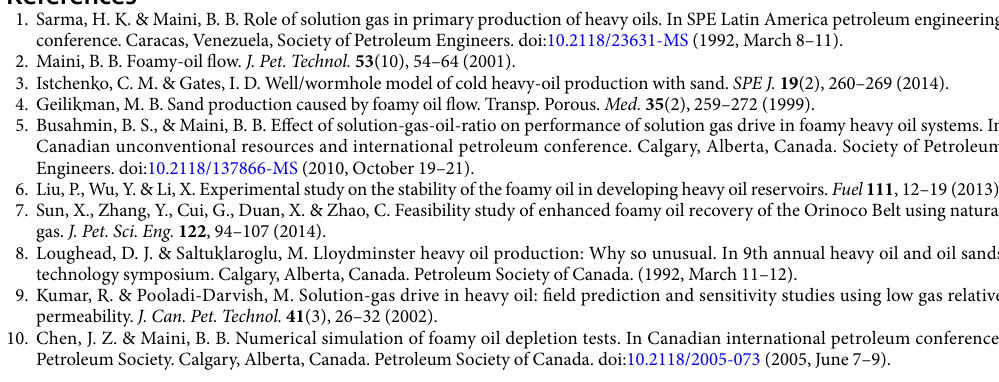
11 Scientific REPORts | 7: 8534 | DOI:10.1038/s41598-017-08882-2